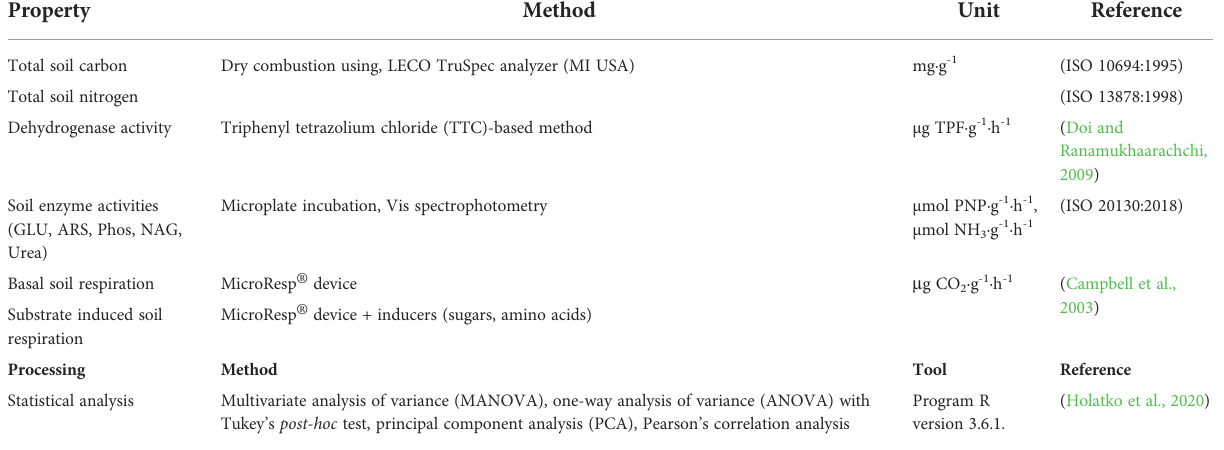
TABLE 1 Determined soil properties, methods used for measurement and statistics, relevant